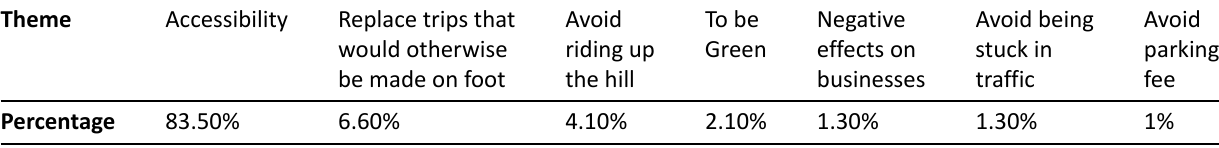
Table 2. Results of the content analysis categorized by themes.